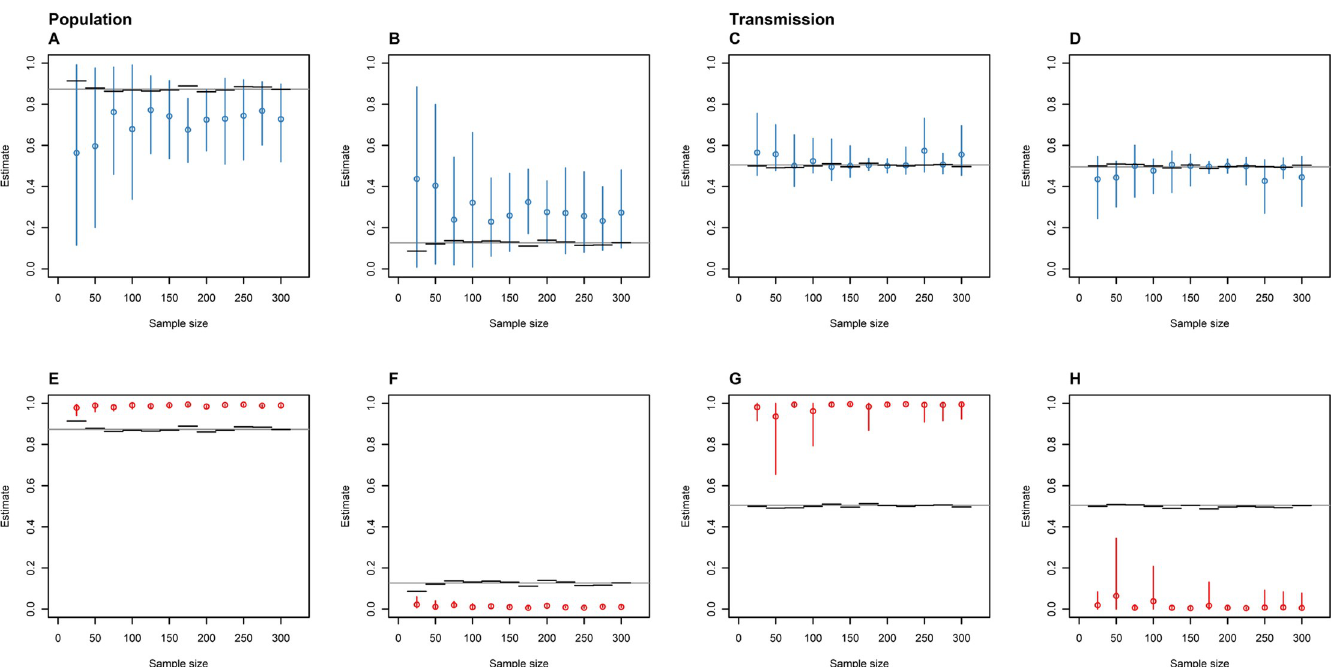
Fig 3. The proportion of time spent in the animal (A and E) and human (B and F) host populations, and the proportion of inter-population transmissions made up of animal-to-human (C and G) and human-to-animal (D and H) transmissions as estimated by the SC (blue: A-D) and DTA (red: E-F) models versus the number of isolates sampled from the same outbreak. The circles represent the mean, the error bars represent the 95% HPD interval, the black horizontal lines represent the known parameters for the sampled outbreaks, and the grey horizontal lines represent the known parameters for the entire outbreak.